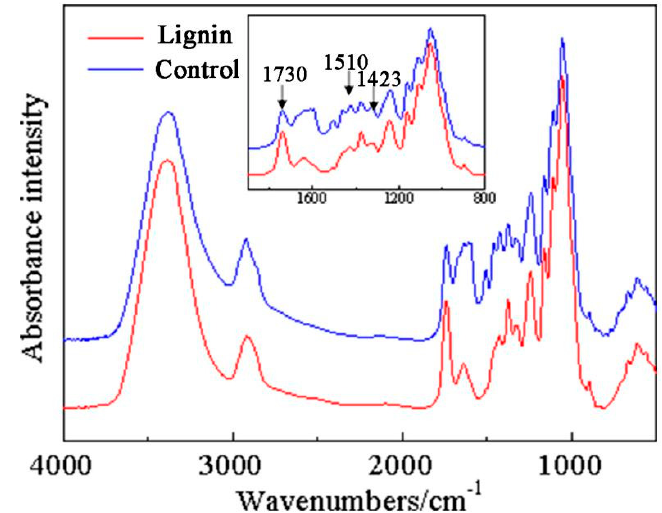
Figure 2. Infrared spectra and local amplified infrared spectra of PCF during chemical purification.